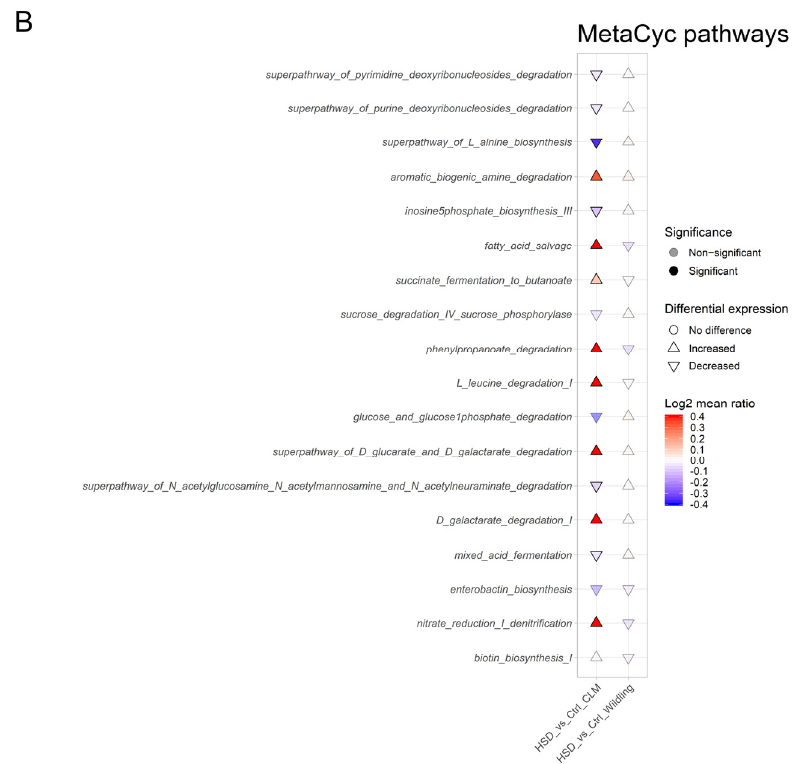
Figure 5. Effect of HSD on gut predictive metagenomic functions in CLM (n = 10/group) and wildling (n = 11 for wildling Ctrl and n = 12 for wildling HSD) gut microbiota. PICRUSt2 output plotted as cuneiform plot for KEGG Orthology annotation ( A ) and MetaCyc pathways ( B ) expressed as log2 mean ratio of the predictive functions counts between HSD vs. Ctrl samples. All statistical comparisons were performed between Ctrl vs. HSD groups by Wilcoxon-test.